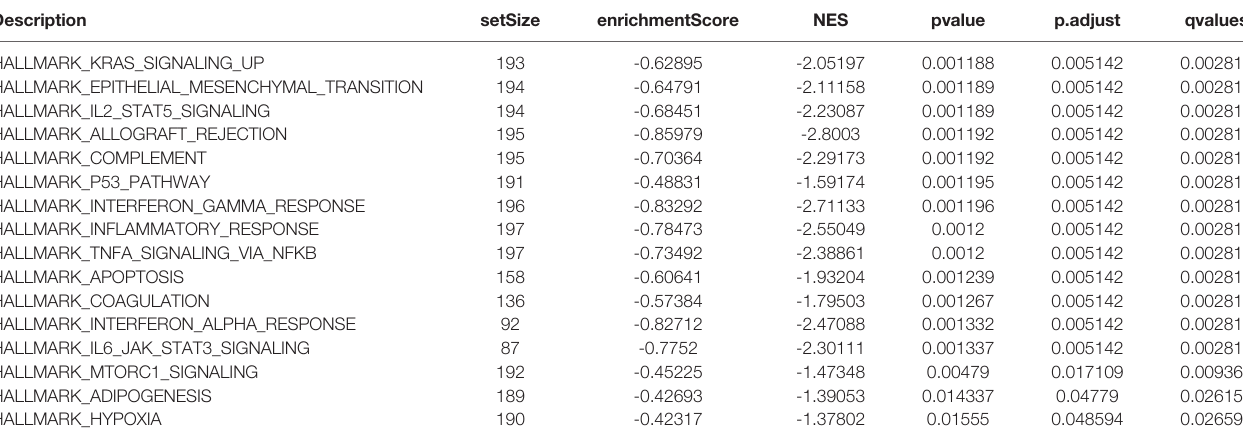
TABLE 1 | GSEA analysis of the differential genes in cluster A and cluster B groups. Description setSize